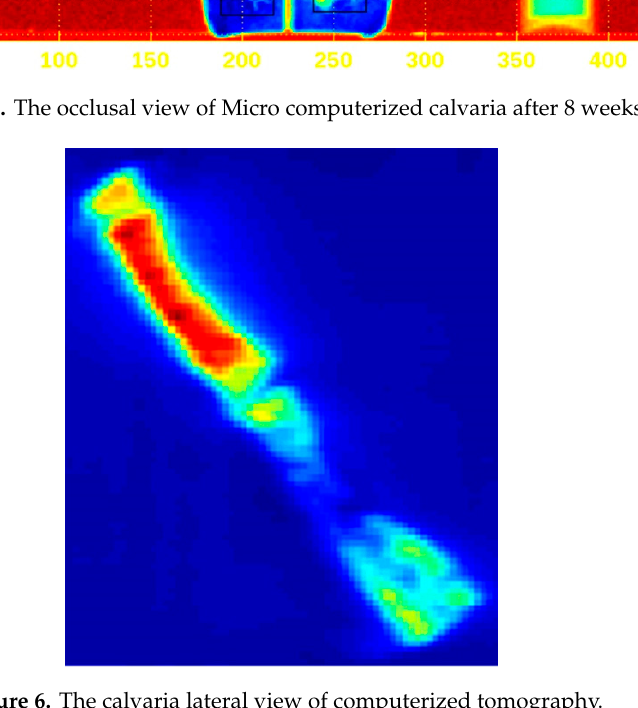
Figure 6. The calvaria lateral view of computerized tomography. Materials 2019 , 12 , x FOR PEER REVIEW